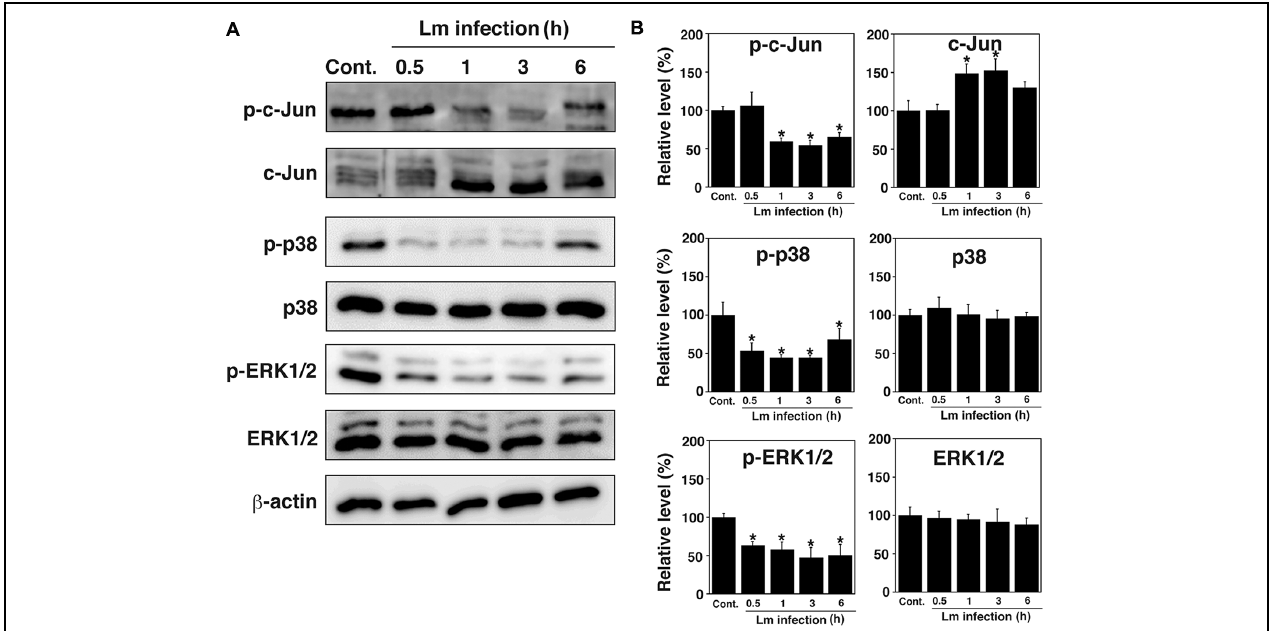
FIGURE 1 | Dephosphorylation of MAPK family proteins in trophoblast giant (TG) cells by Listeria monocytogenes infection. (A) Expression of MAPK family proteins in TG cells infected with L. monocytogenes . TG cells were infected with or without (Cont.) L. monocytogenes for the indicated number of hours. Production of the indicated proteins was detected by immunoblotting. β -actin was used as an immunoblotting control. Phosphorylated c-Jun, p38, and ERK1/2 are designated p-c-Jun, p-p38, and p-ERK1/2, respectively. (B) Relative intensity levels of p-c-Jun, c-Jun, p-p38, p-38, p-ERK, and ERK. The intensity levels of all MAPK family proteins were measured using Multi gauge software and normalized by the value of β -actin. Relative values to the intensity without infection (Cont.) were shown. All values represent the means and SD of three assays. ∗ P < 0.05 compared with Cont. by post hoc Tukey–Kramer